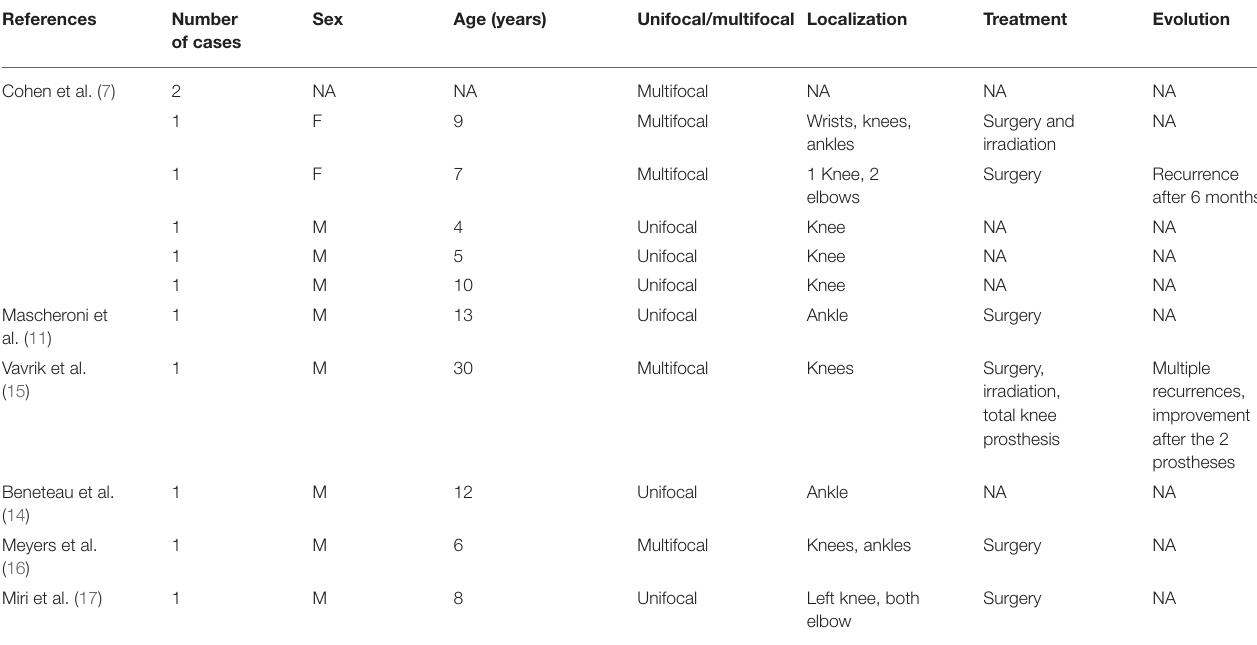
TABLE 1 | Association of Noonan syndrome and villonodular synovitis in the literature.